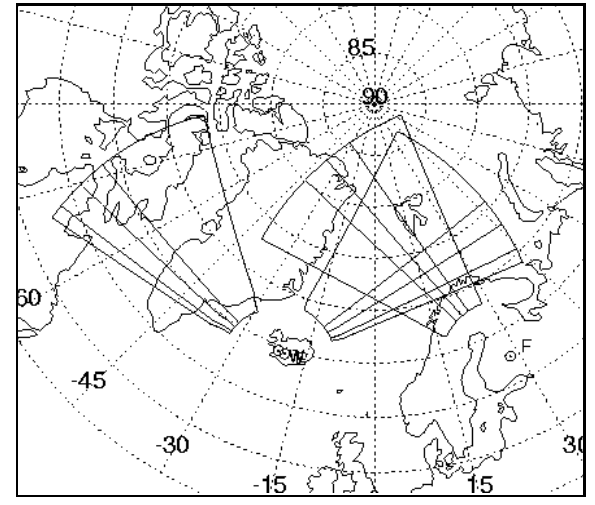
Fig. 2. Geometry of the fields-of-view of the SuperDARN radars. The directions of the high-time resolution beams are also